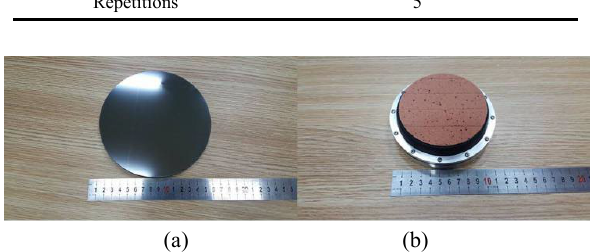
Fig. 9 Workpiece and polishing tool for experiments: (a) 150-mm RB-SiC and (b) 100-mm RC lap.